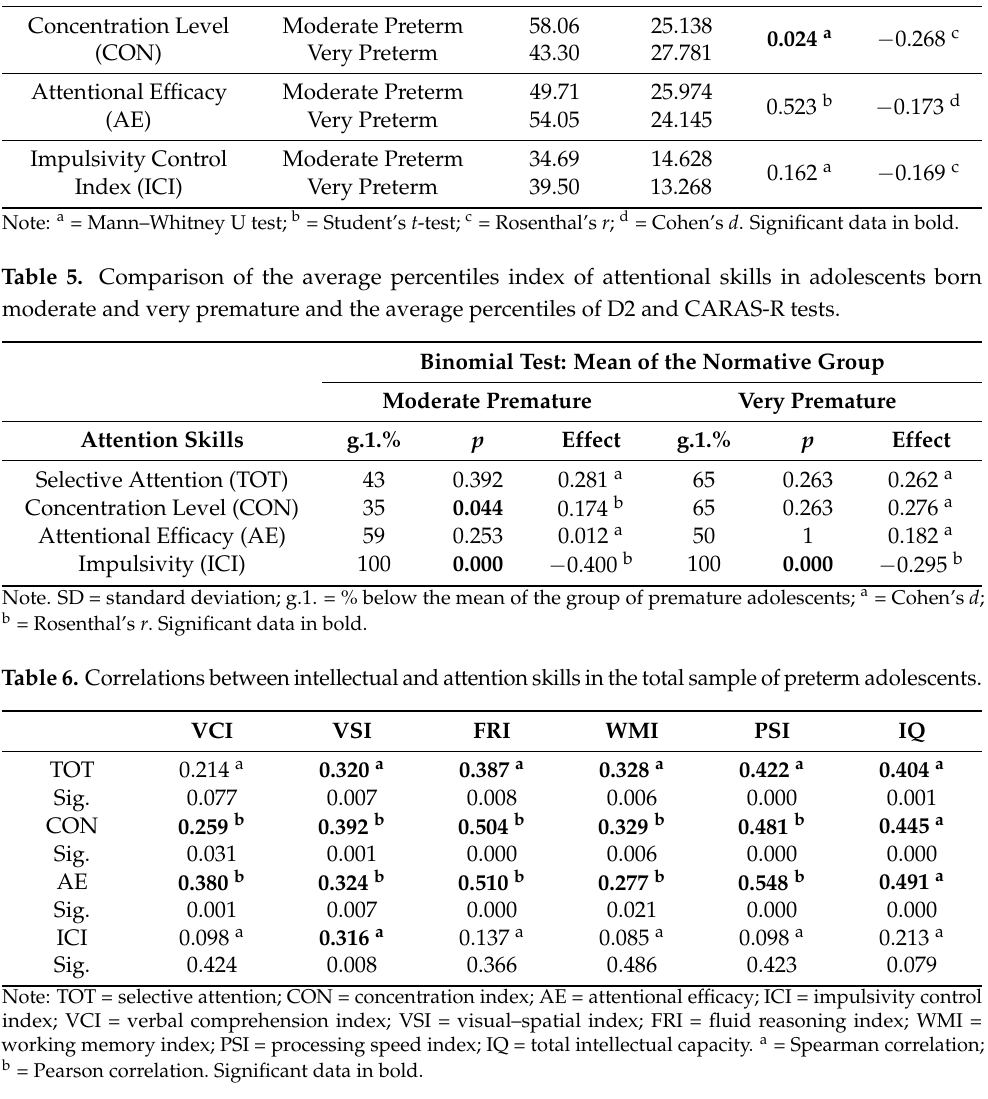
Table 4. Average reached in the attention skills according to the preterm categories. D2 and CARAS-R